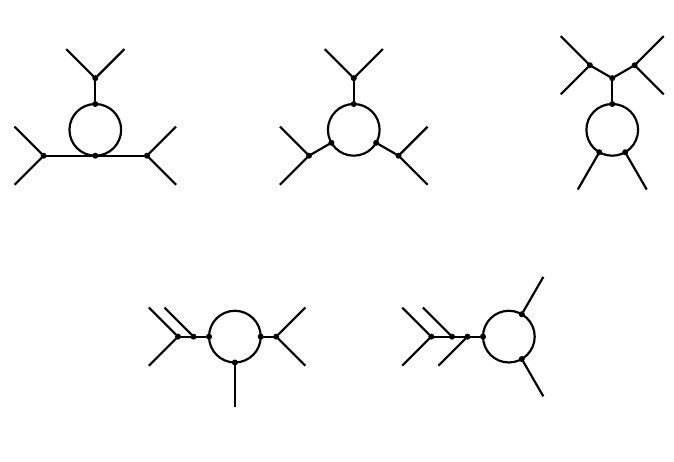
Figure 15 . The one-loop topologies leading to non-genuine diagrams.